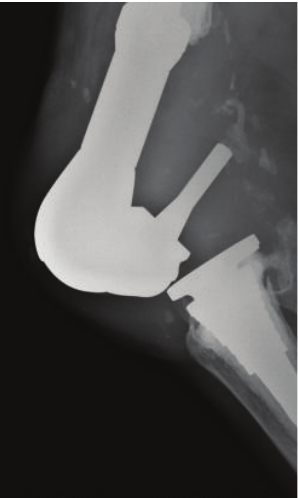
Figure1:Preoperativelateralradiographillustratingdisengagement and posterior dislocation of the hinge post in close proximity to the location of the popliteal